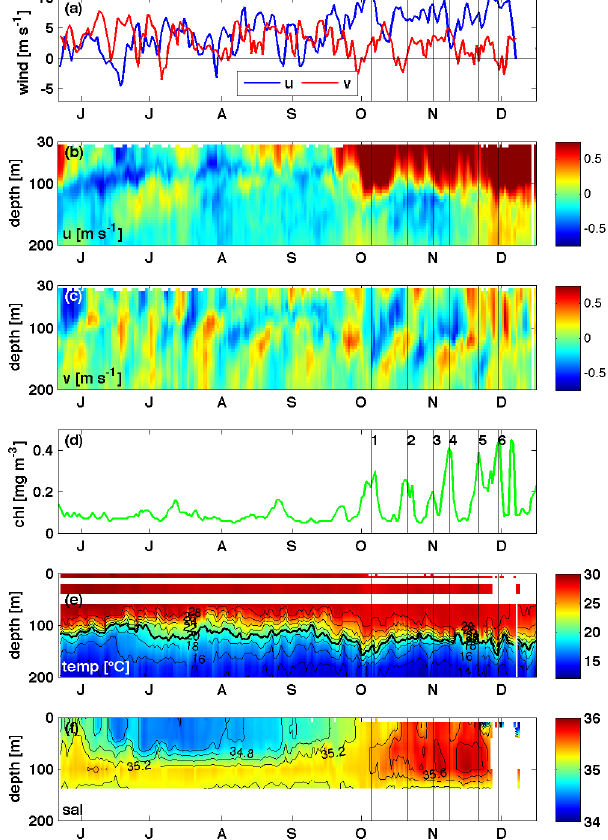
Figure 3. Time series of mooring physical and biological param- eters. (a) Zonal ( u , ms − 1 ) and meridional ( v , ms − 1 ) winds; (b) zonal ( u , ms − 1 ) current; (c) meridional ( v , ms − 1 ) current; (d) chlorophyll concentration (mgm − 3 ) from the moored fluorometer; (e) temperature ( T , ◦ C) with 20 ◦ C contour in bold; (f) salinity. Gaps in the T and S data are due to sensor failure. Vertical black lines in each panel indicate the six main chlorophyll peaks during October to December, which are numbered in panel (d)